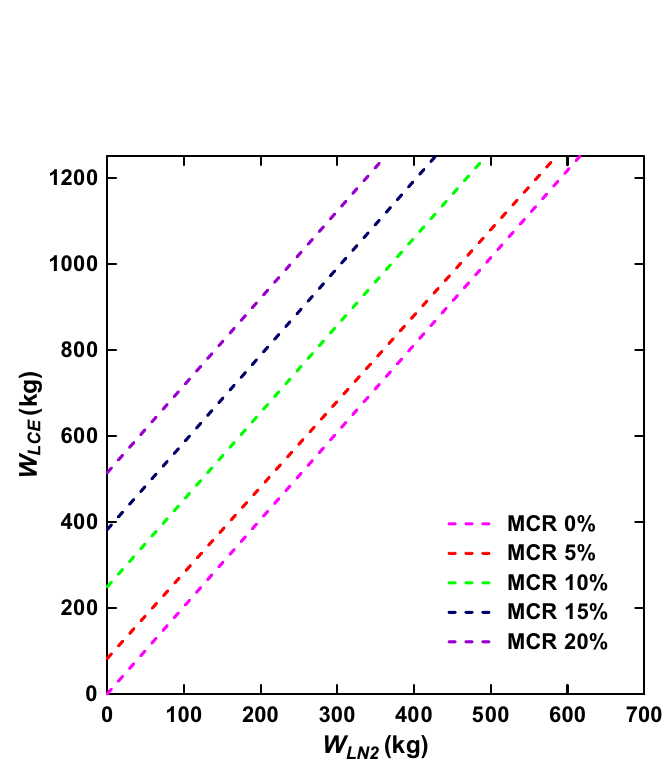
Figure 4. MD freezing capacity compared to liquid nitrogen consumption according to the ship’s